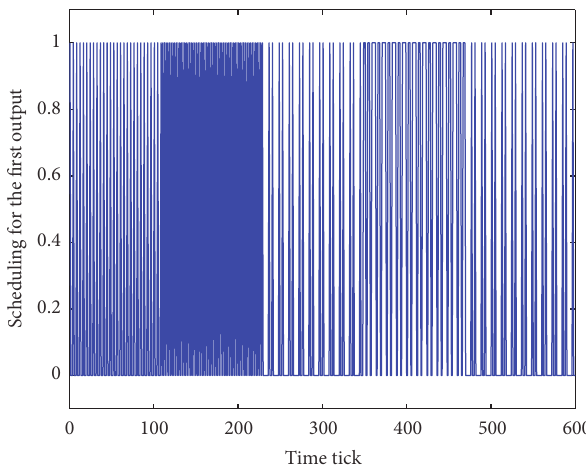
Figure 9: Scheduling of 𝑦 1 (𝑡) by the proposed